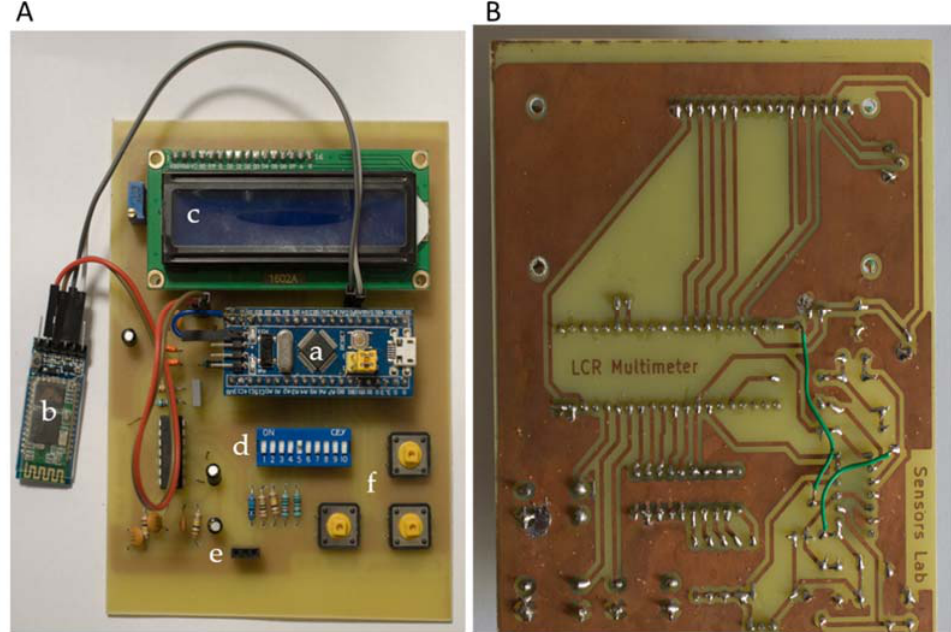
Figure 3. The prototype PCB; ( A ) front side of the board: (a) Blue Pill STM32 development board; (b) HC-05 BT module; (c) LCD screen; (d) DIP switches; (e) input pins; (f) settings buttons; ( B ) back side of the board.